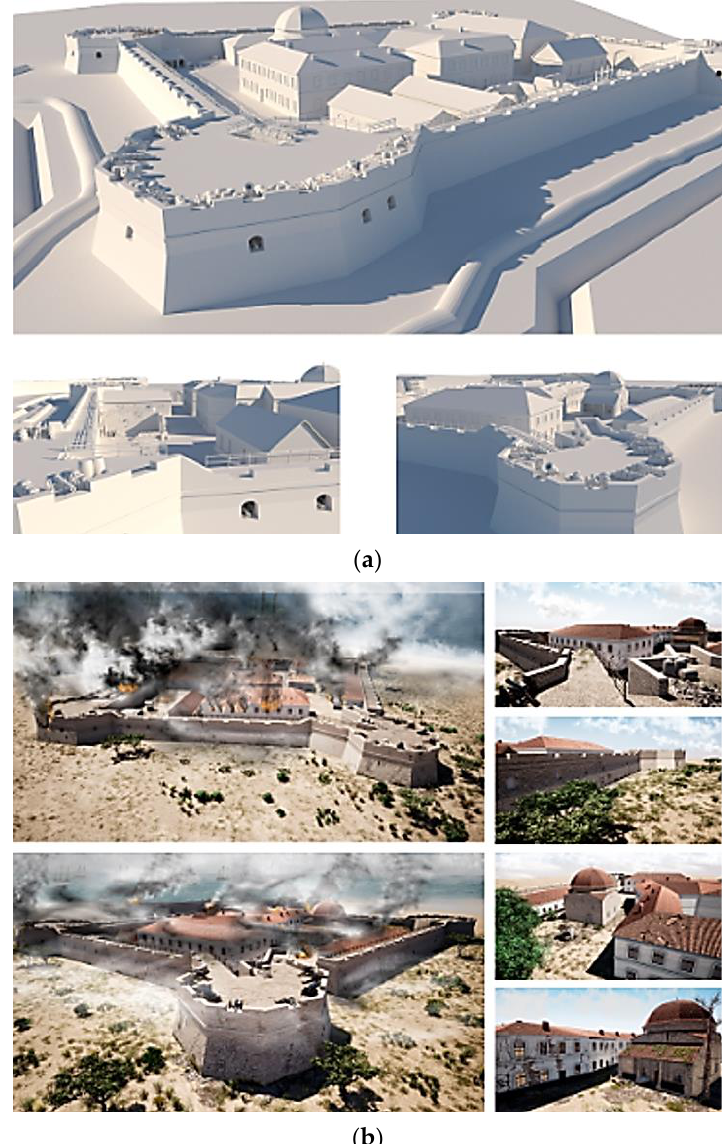
Figure 8. The final model ( a ) and its visualization ( b ).